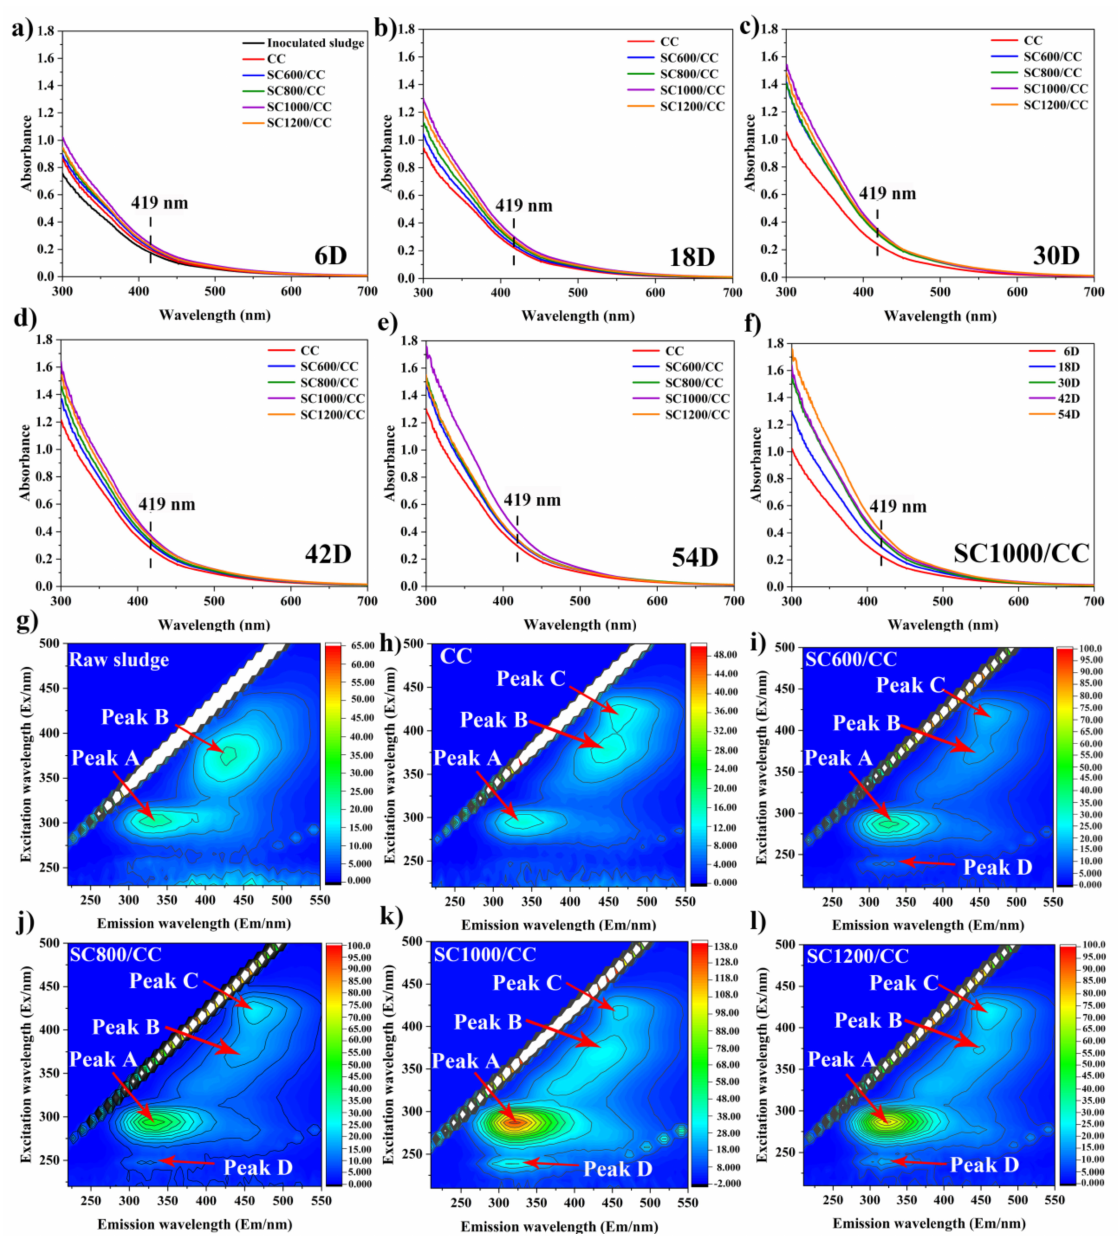
Figure 8. Absorbance of c-Cyts for inoculated sludge and different anodic biofilms at MFCs on ( a ) 6D, ( b ) 18D, ( c ) 30D, ( d ) 42D, and ( e ) 54D. Absorbance of c-Cyts for ( f ) SC1000/CC. EEM fluo- rescence spectra of EPS extracted from ( g ) inoculated sludge, ( h ) CC, ( i ) SC600/CC, ( j ) SC800/CC, ( k ) SC1000/CC, and ( l ) SC1200/CC anode biofilms at MFCs after 54 d of batch mode